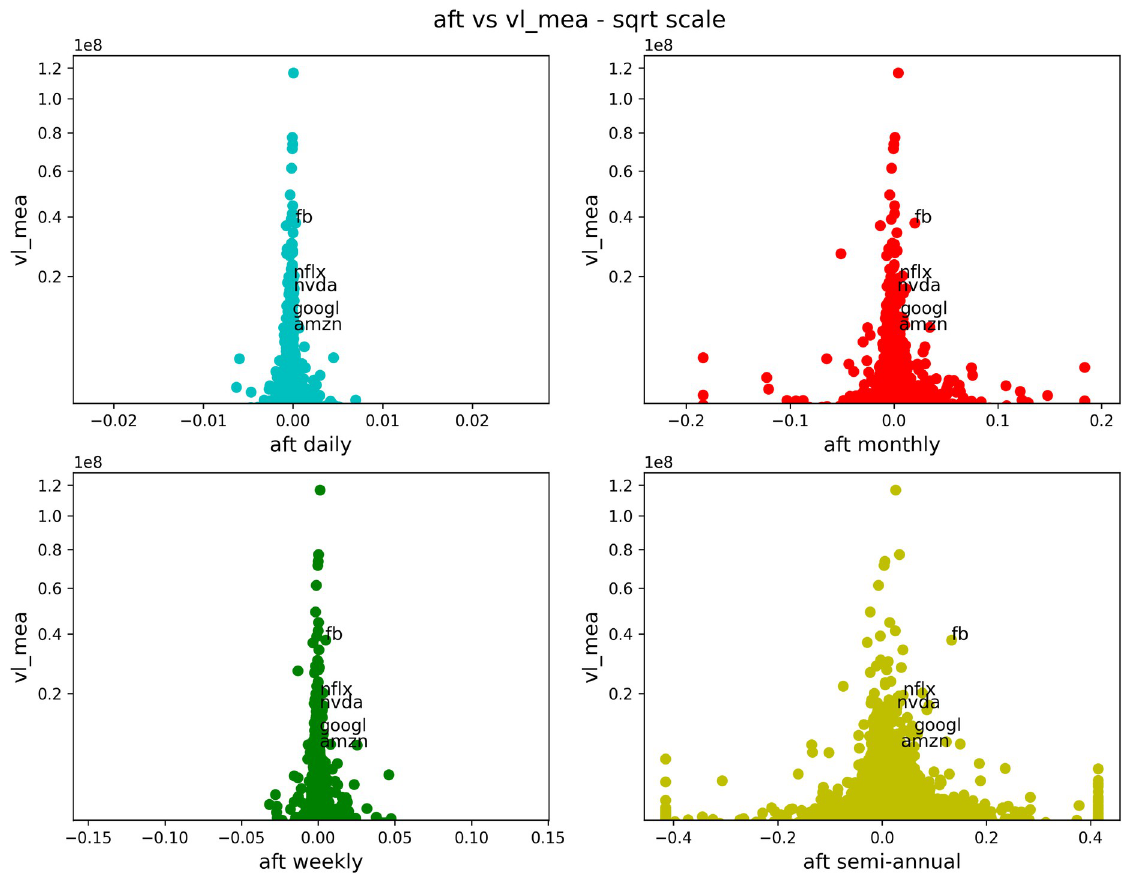
Fig 6. Comparison of antifragility values and measure vl_mea in stocks. Each subplot corresponds to a timescale (daily in cyan, weekly in green, monthly in red, semiannual in yellow). The plots compare the antifragility A measure (in the x -axis) to vl_mea of each asset. We observe how higher values of the ‘good-performance’ measure concentrate in the robust axis A = 0